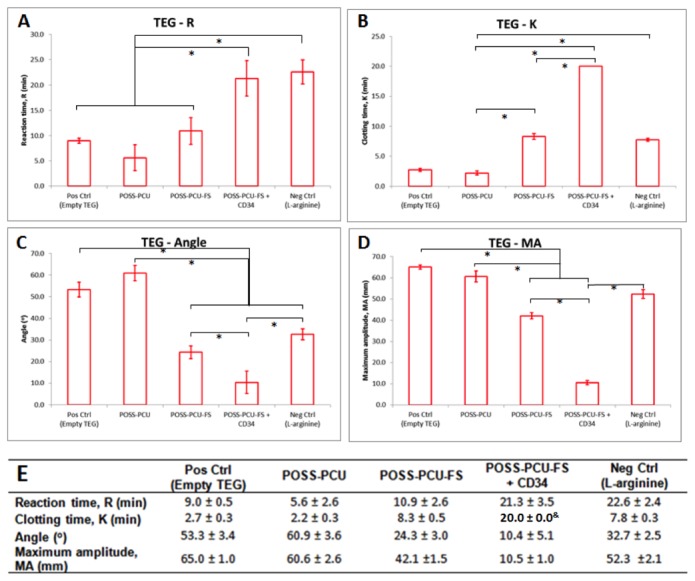
TEG parameters.Samples differed in (A) reaction time, (B and C) clotting rate, and (D) maximum clot strength. The mean of each clotting parameter was plotted (n=3). Error bars: ± SD; *denotes p < 0.05. (E) Table representing mean TEG parameters. &Anti-CD34-coated samples never reached 20 mm clot size after 1.5 hrs of testing, hence k value was set as 20 min for ease of statistical testing. Standard unmodified TEG cups with citrated whole blood were used as positive controls, whereas standard-coated cups containing citrated blood mixed with the anti-coagulant L-arginine were used as negative controls.POSS-PCU-FS: POSS-PCU with fumed silica anchors, POSS-PCU-FS+CD34: POSS-PCU biofunctionalized with anti-CD34 antibodies.